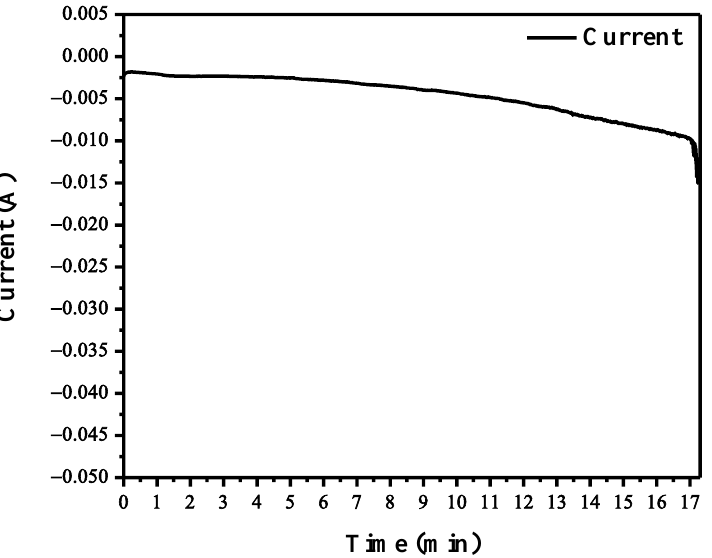
Figure 6. CPE for FTO modified with tetra-metallic electrocatalyst coated for 16 h. Table 3. Comparison of different metal-based heterogeneous catalysts for oxidation of water in KOH.